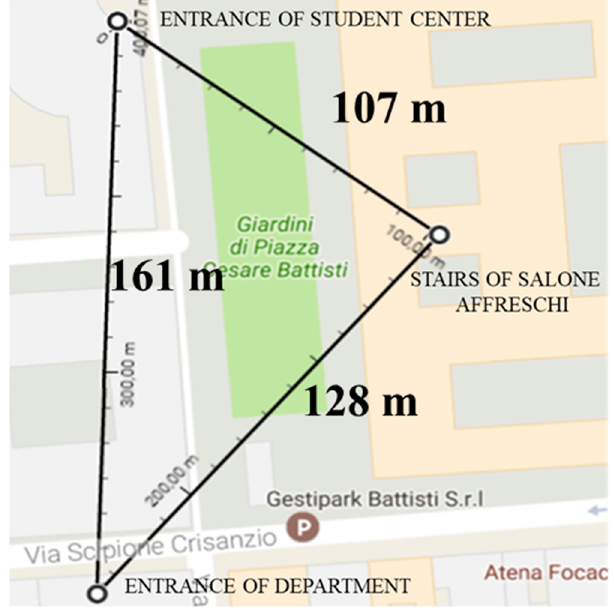
Figure 2. Campus area of the University of Bari and distances between landmarks. Illustration from Google Maps (https://maps.google.com, accessed on 6 September 2022).